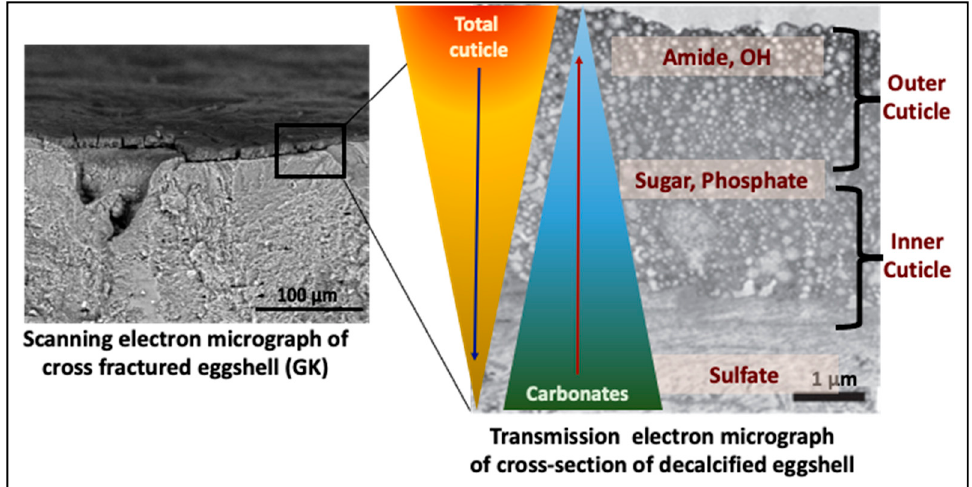
Figure 8. The proposed compositional gradient in the eggshell cuticle with predicted distribution of proteins, phosphoproteins, glycoproteins, and sulphated proteoglycans. proteins, phosphoproteins, glycoproteins, and sulphated